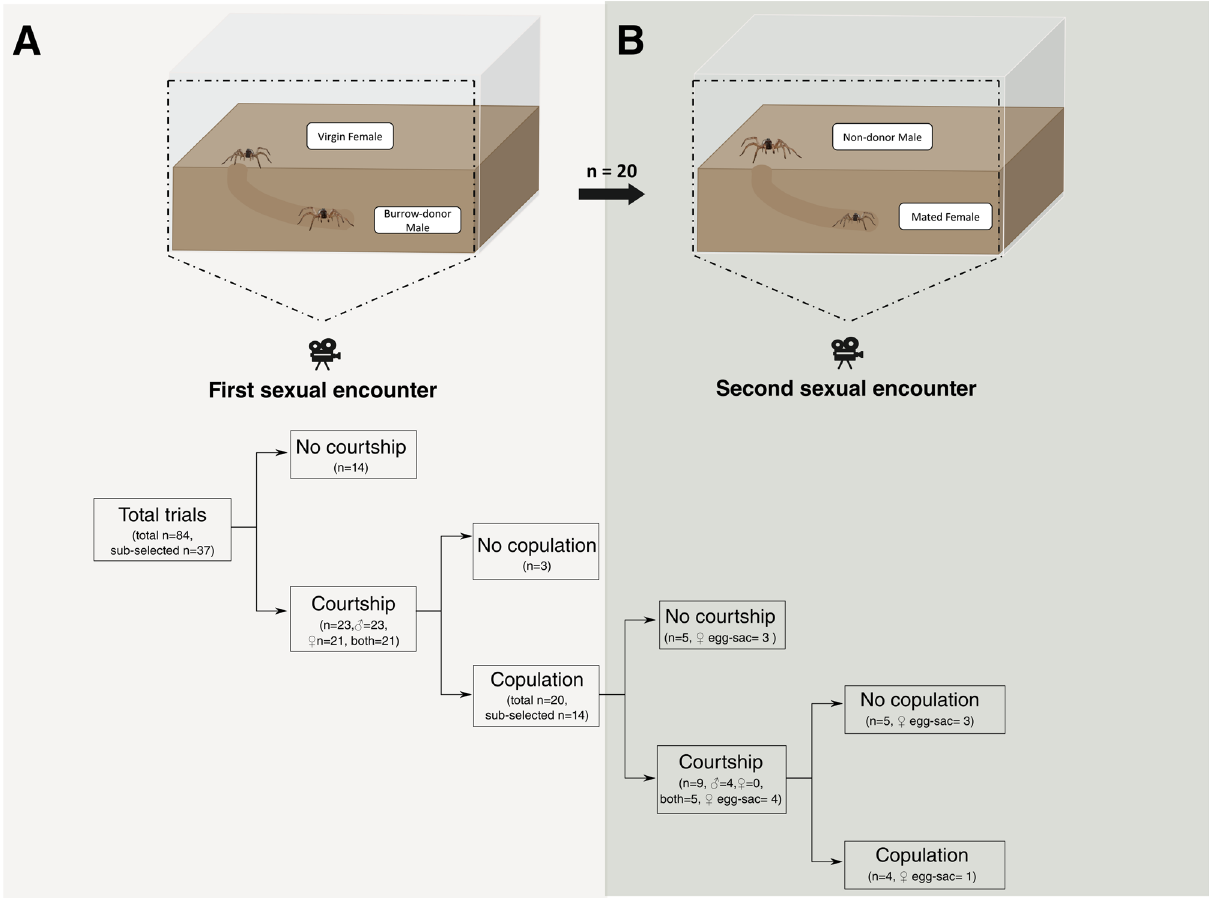
Figure 1. Scheme of the experiment (above) and flow chart of trials outcome (below). The illustration on ( A ) represents the first sexual encounter with a burrow-donor male, and the illustration on ( B ) represents the second sexual encounter with a non-donor burrow male. Arrows indicate the progression of events and/or the circumstances in which they occurred. The numbers of trials are given in parentheses. Since in numerous trials some individuals did not interact with each other and/or did not perform any movement at all, to calculate the real probabilities of courtship and copulation during the sexual encounters, we sub-selected from the total number of interactions those in which at least one of the individuals noticed the other one. We considered the following indicator criteria: (1) the individual remained outside the burrow entrance for at least 5 s, and/or (2) the individual inside the burrow moved towards the burrow